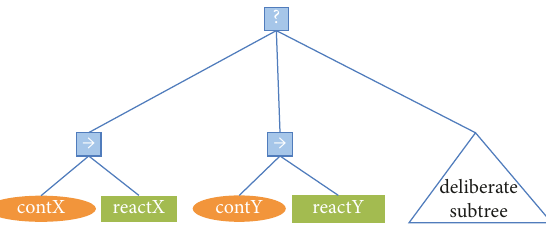
Figure 11: Handling contingencies by adding reactivity to the